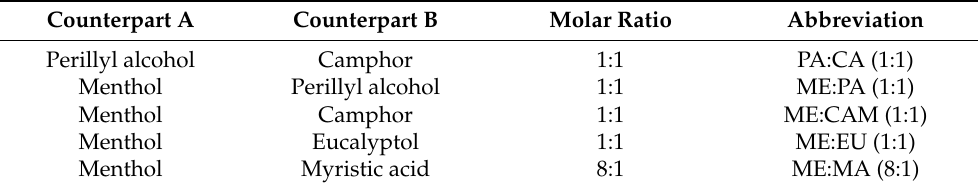
Table 2. Natural deep eutectic systems containing various terpenes as powerful inhibitors of HT-29 cell proliferation. Counterpart A Counterpart B Molar Ratio Abbreviation Perillyl alcohol Camphor 1:1 PA:CA (1:1) Menthol Perillyl alcohol Menthol Camphor